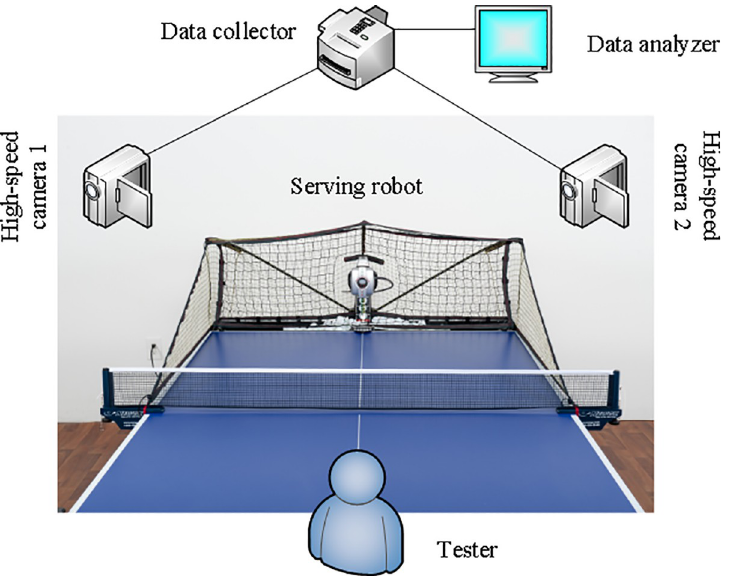
Fig 7. Real-time data acquisition system.